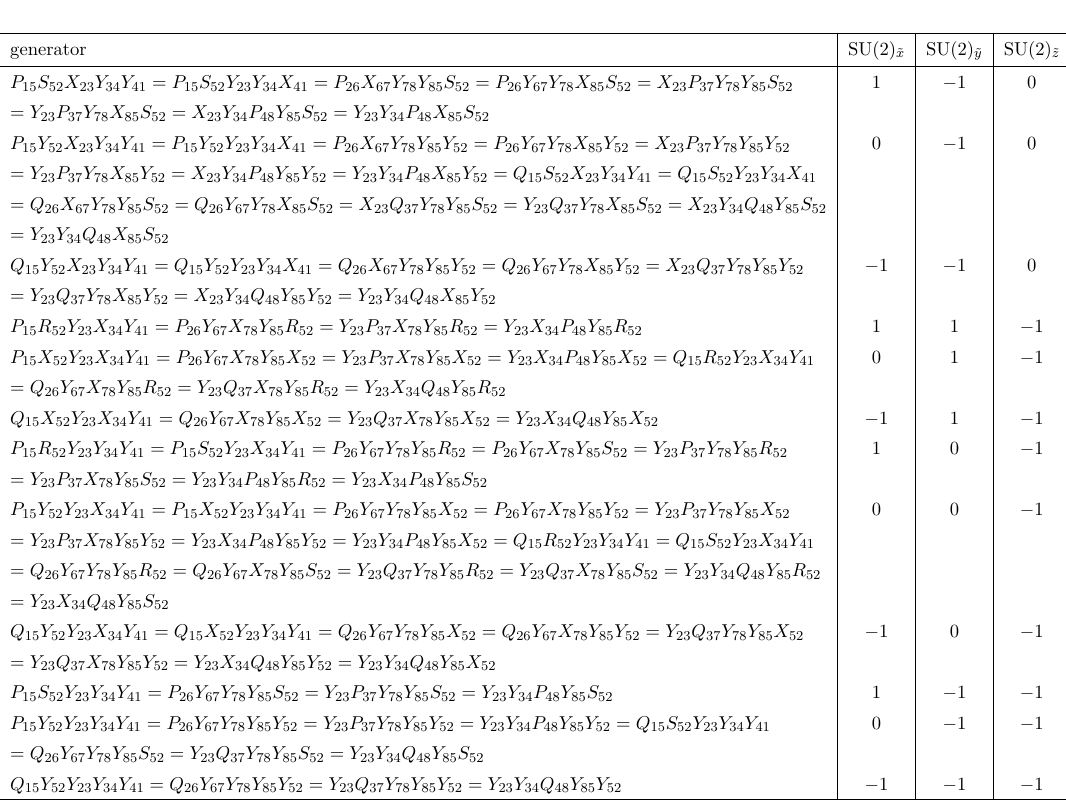
Table 50 . The generators in terms of bifundamental chiral fields for Model 12 (Part 2)